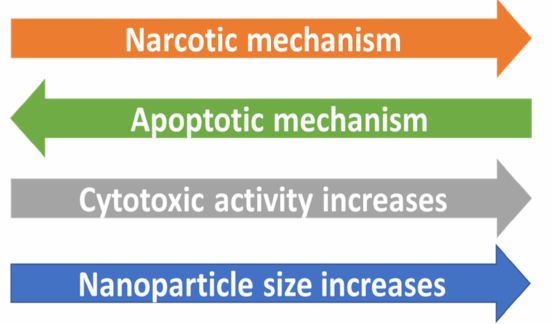
Figure 10. The proposed relationship between the size of the silver nanoparticles and cytotoxic activity and the mechanism of inhibition of the different applied cancer cells in the current